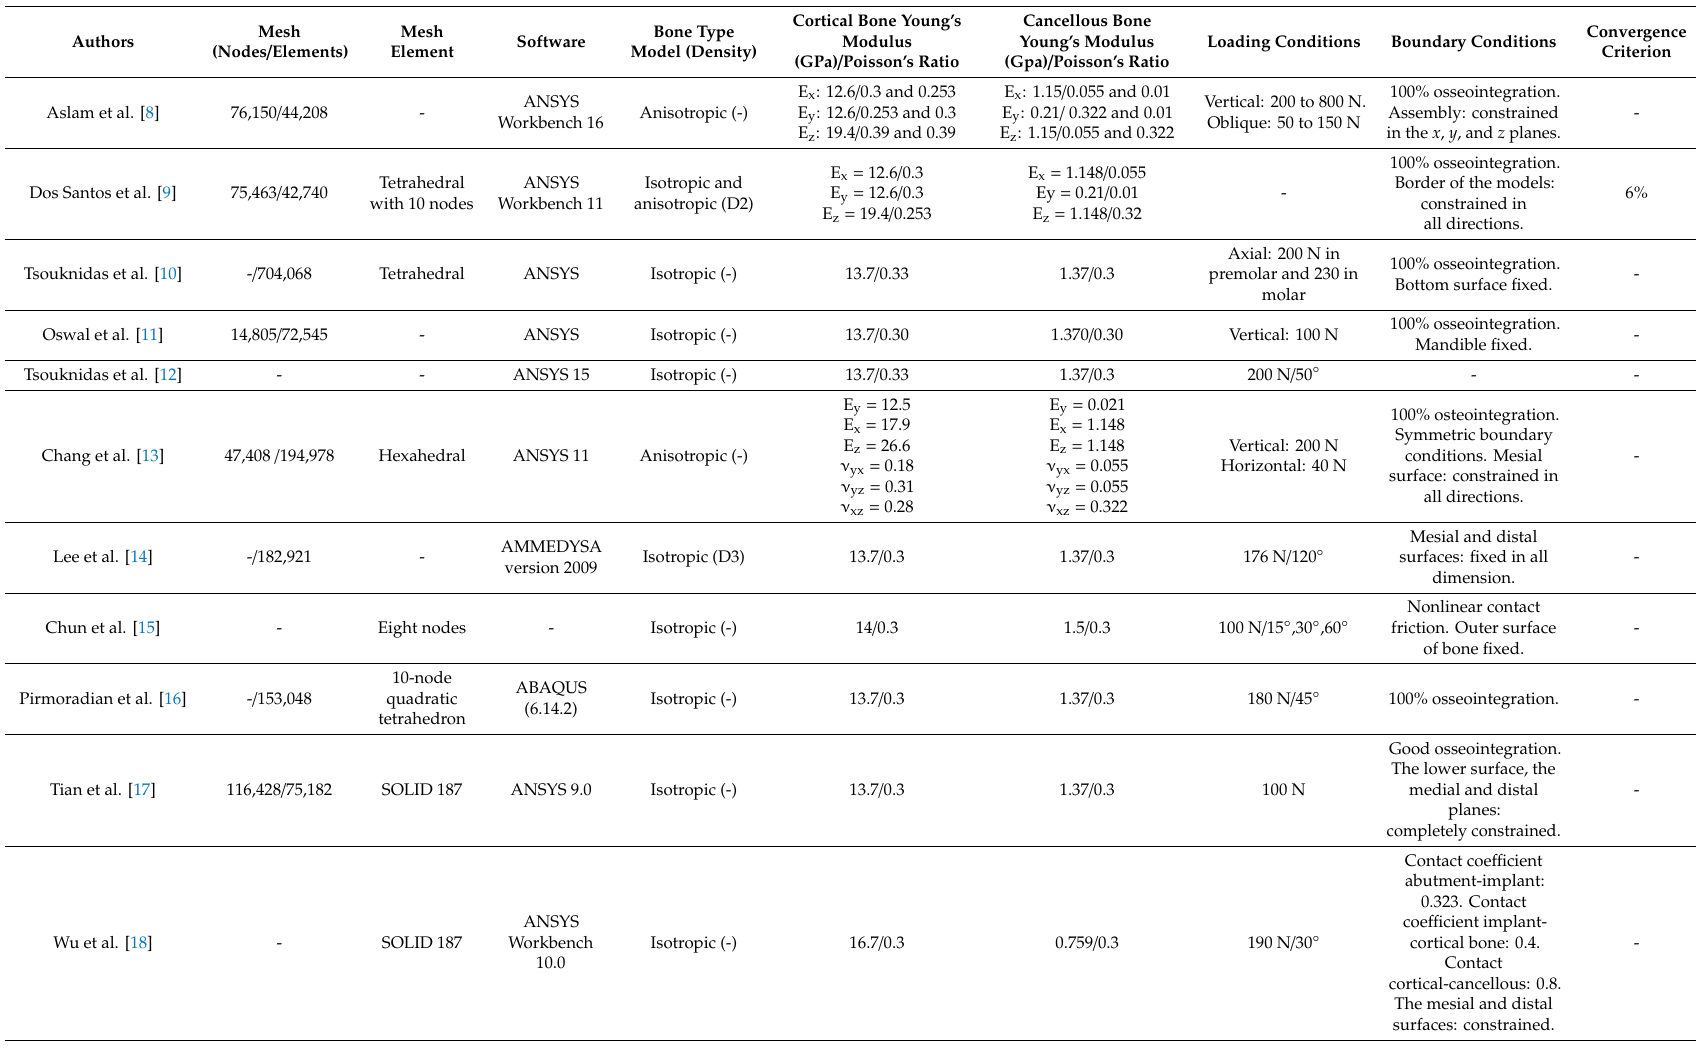
Table 3. Finite elements